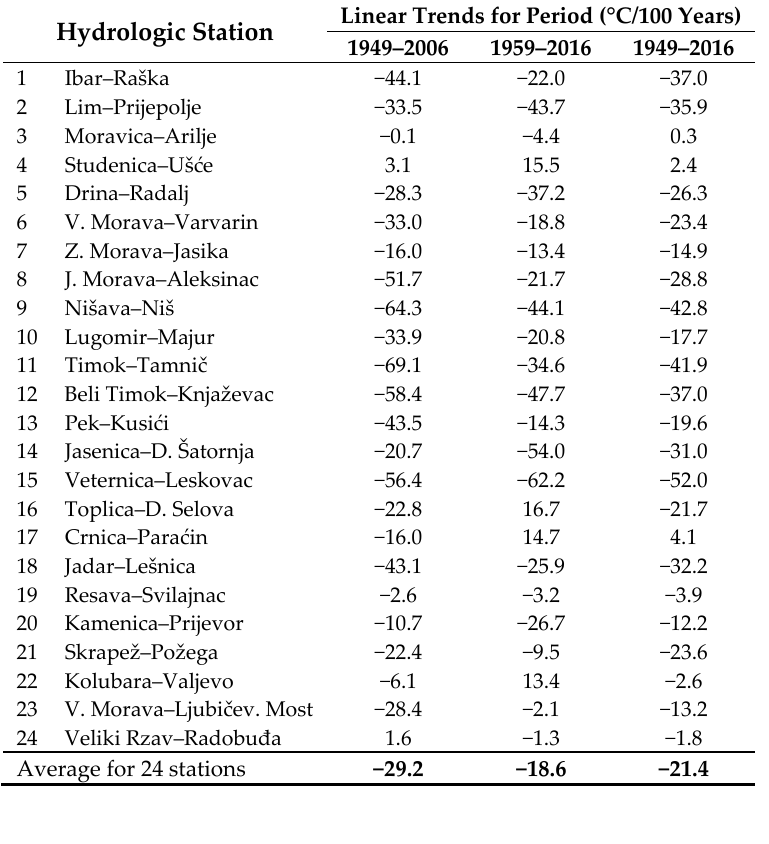
Table 3. Selected Q stations with observed annual trends for analyzed